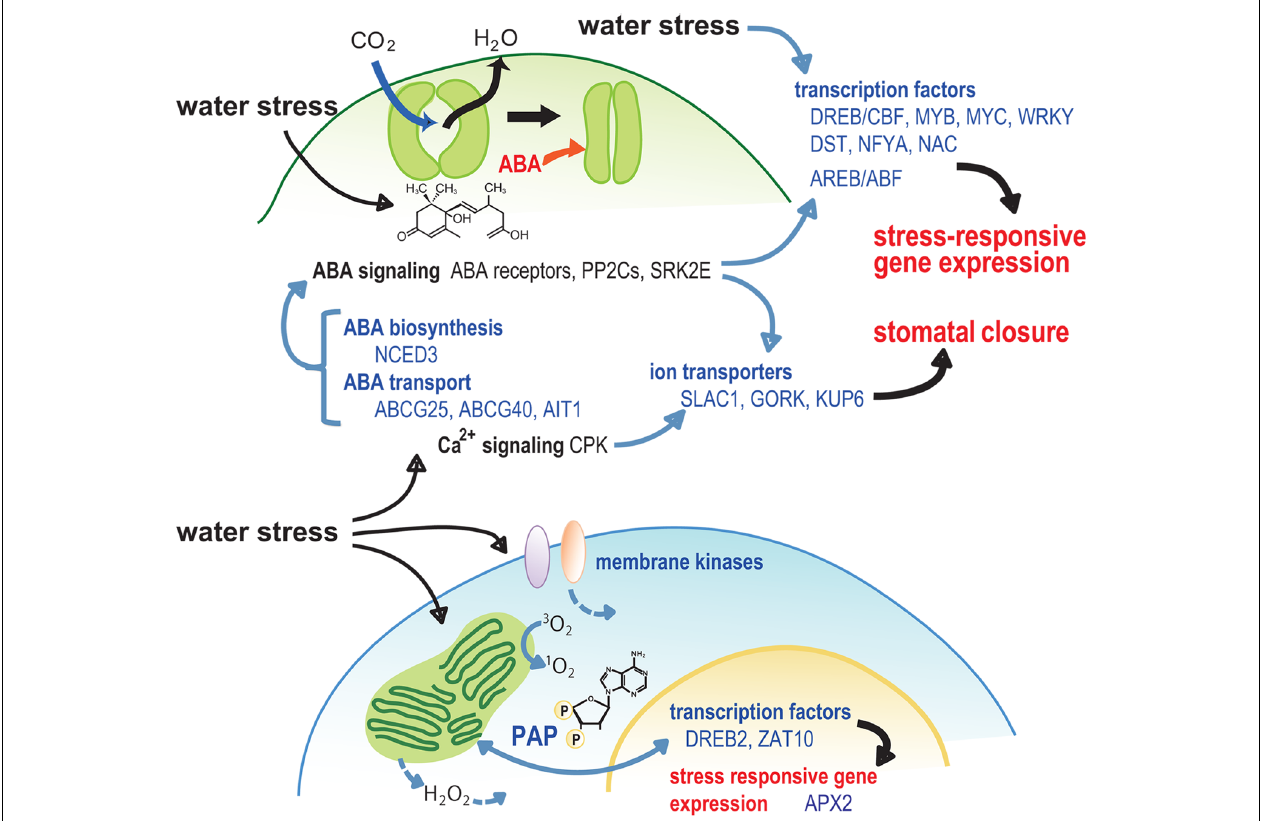
FIGURE 2 | Model for the role of signaling factors in stomatal closure and retrograde signaling during water